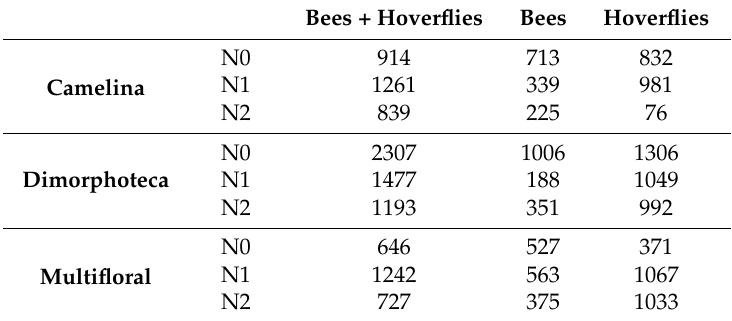
Table 3. Hill diversity indices of each treatment based on abundance data of hoverflies and bees together, bees alone and hoverflies alone where N0 = species richness; N1 = evenness; N2 = diversity weighted by relative abundance. Bees + Hoverflies Bees Hoverflies